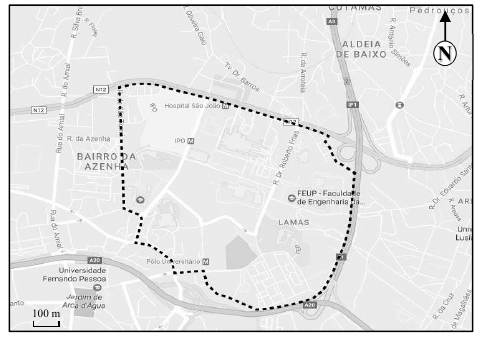
Figure 2. Area of the university campus of Asprela (Google Earth, 2017).